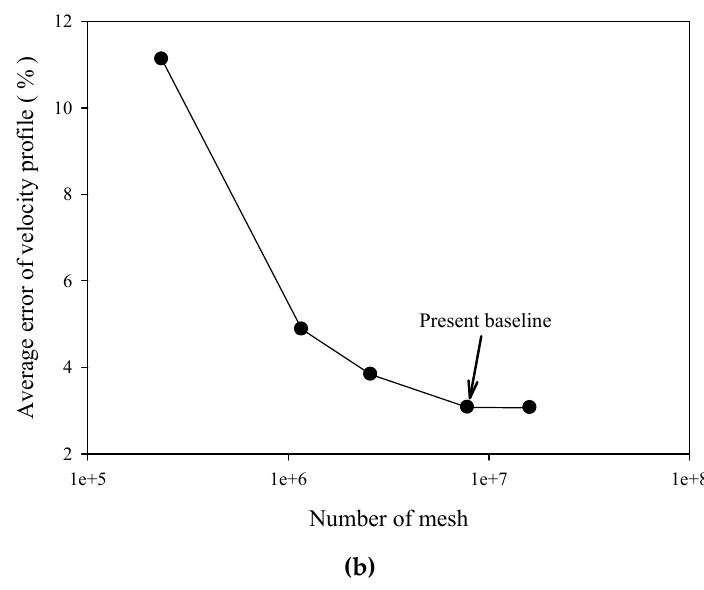
Figure 4. Mesh convergence test: ( a ) velocity profile; ( b ) average error of analysis and experiment data [14].